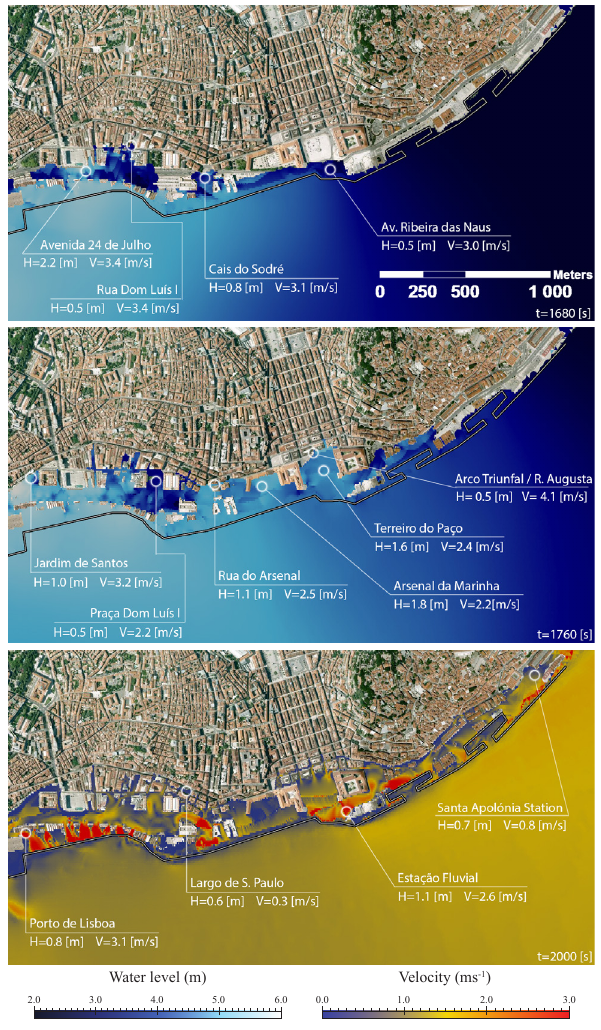
Fig. 11. Results for downtown Lisbon. Water level at 15min (top) Fig. 11: Results for Downtown. Water level at 15 (Top) and and 16min (center); velocities at 20min (draw-down, bottom). Fig. 11: Results for Downtown. Water level at 15 (Top) and 16 min (center); velocities at 20 min (Draw-down, bottom) 16 min (center); velocities at 20 min (Draw-down, bottom)